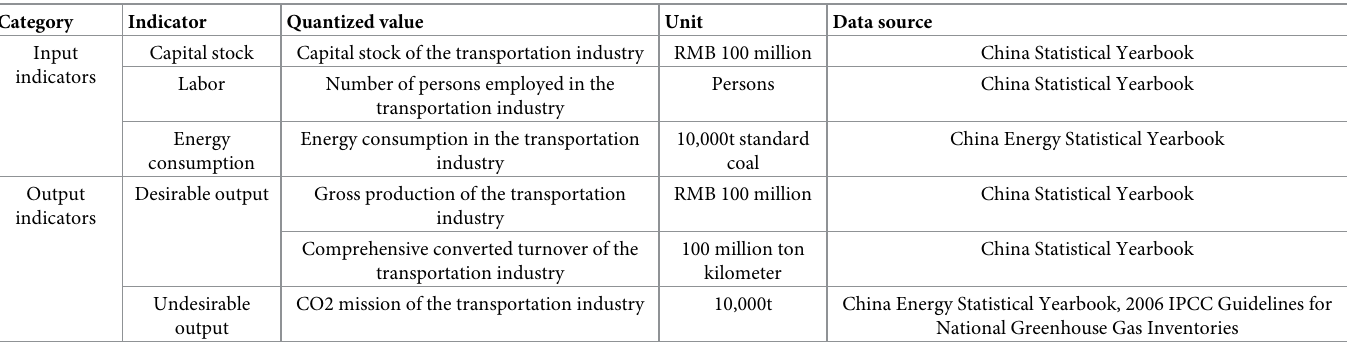
Table 1. Indicators used to assess unified economic and environmental efficiency of transportation infrastructure.